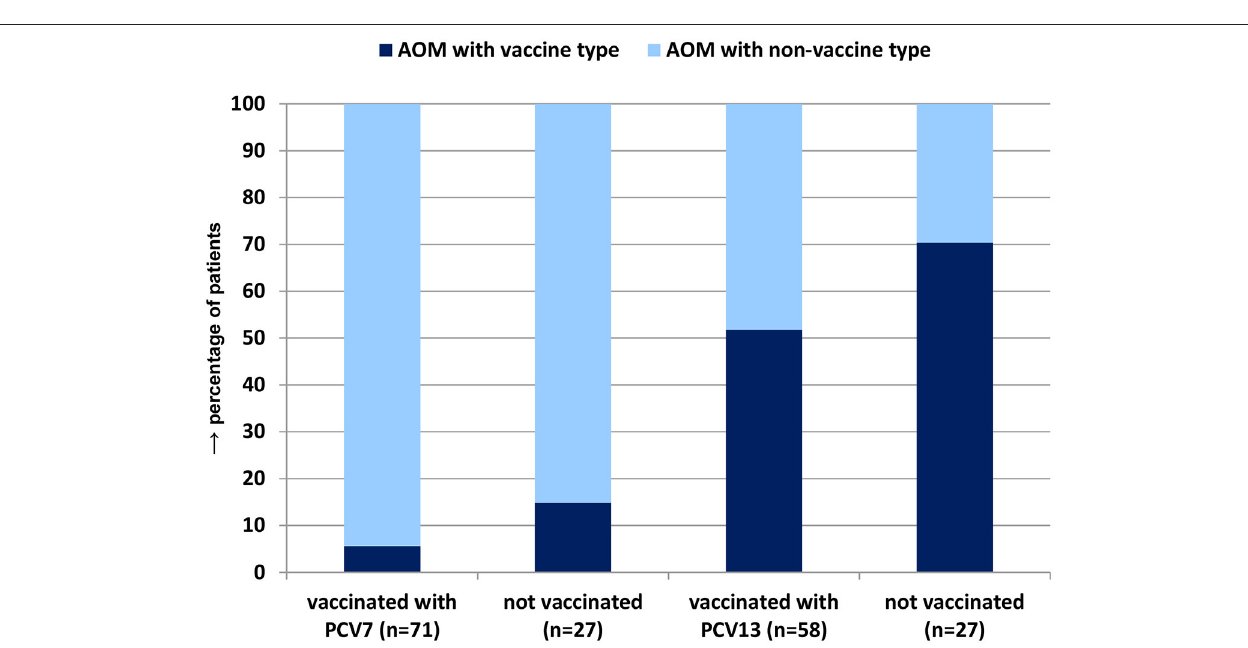
FIGURE 7 | Percentage of S. pneumoniae vaccine type severe spontaneously ruptured AOM among patients vaccinated with PCV7 or PCV13 vs. non-vaccinated patients.